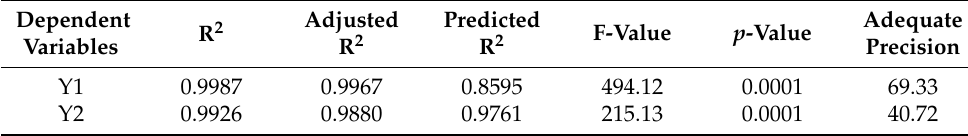
Table 2. Regression analysis results for Y 1 and Y 2